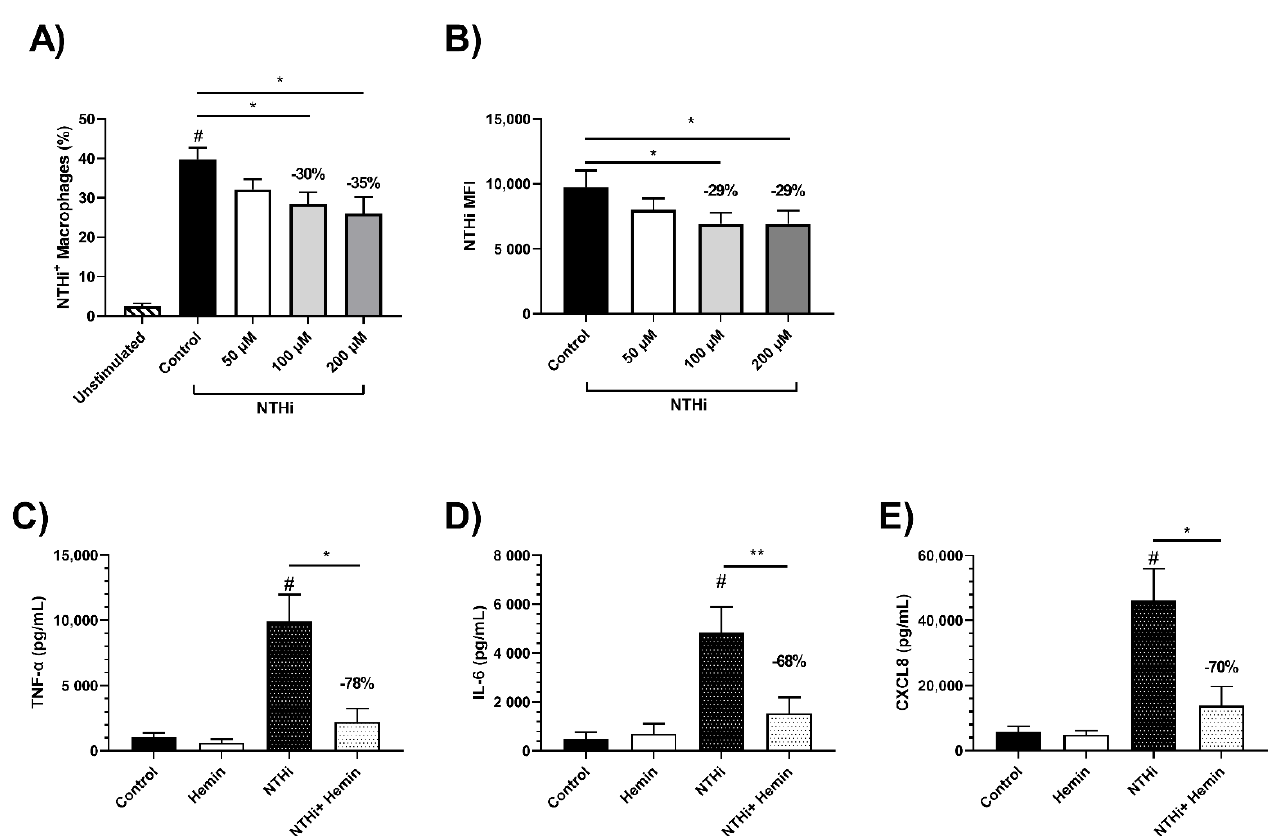
Figure 6. Phagocytosis and cytokine response following NTHi stimulation in hemin-treated MDMs. Monocyte-derived macrophages (MDMs) were pre-treated with 50, 100 or 200 µ M of hemin for 24 h followed by exposure to labelled Non- typeable Haemophilus influenzae (NTHi) for 3 h. ( A ) Phagocytosis of FITC labelled NTHi in hemin pre-treated COPD MDMs was measured using flow cytometry. ( B ) Median fluorescent intensity (MFI) of COPD MDMs with labelled NTHi internalised. MDMs from COPD patients and non-smokers were pre-treated with 200 µ M of hemin for 24 h and were subsequently stimulated for a further 24 h with live bacteria ( n = 7). Cytokine production was measured for ( C ) TNF α , ( D ) IL6 and ( E ) CXCL8 in COPD patients and non-smokers. One-way ANOVAs were carried out with a post hoc Dunnett’s multiple comparisons test against untreated/stimulated controls ( A , B ). Relative percentage changed indicated on graph. * = p < 0.05, ** = p < 0.01. Unstimulated vs. stimulated control t -test # = p < 0.05.